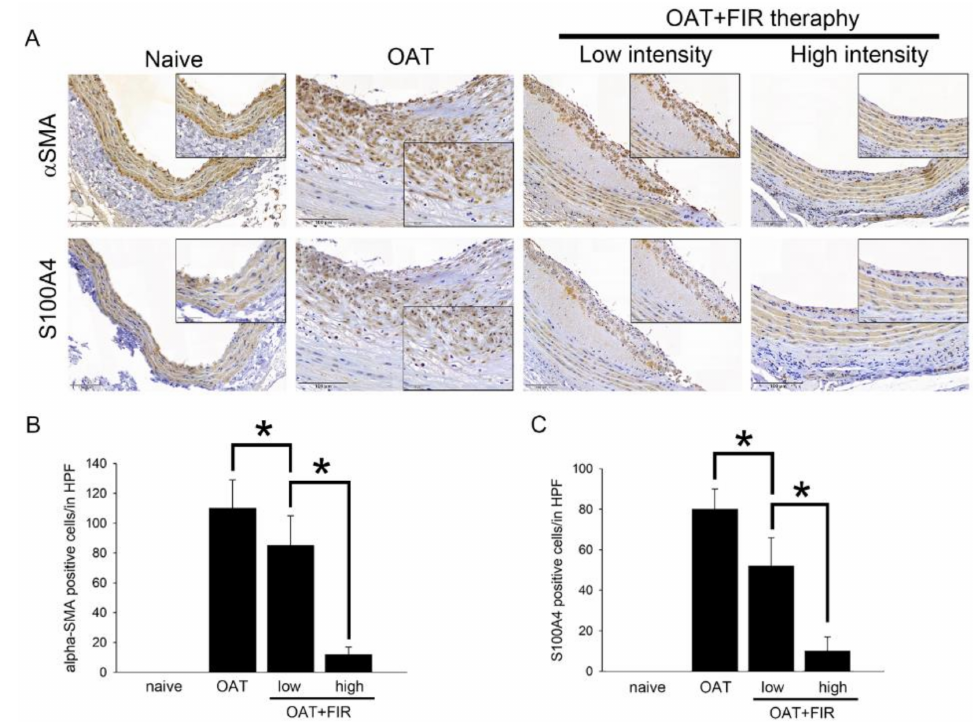
Figure 2. Administration of FIR therapy is effective against SMC and fibroblast activity in OAT- induced chronic allograft vasculopathy. ( A ) Immunohistochemistry to assess proliferated SMCs ( α SMA) and fibroblasts (S100A4) in rat thoracic aortas from donor PVG/Seac rats. The lumen is uppermost in all sections; the images are 200 × magnified. Similar regions are shown as enlarged images (400 × magnification) in the black corners. The brown signal indicates α SMA- and S100A4- positive cells. ( B , C ) The quantification of cells in high power field (HPF) is displayed in ( B , C ). The graphs demonstrate the accumulation of cells in the aortas of rats. The results are expressed as the mean ± SD. * p < 0.05 was taken into consideration statistically